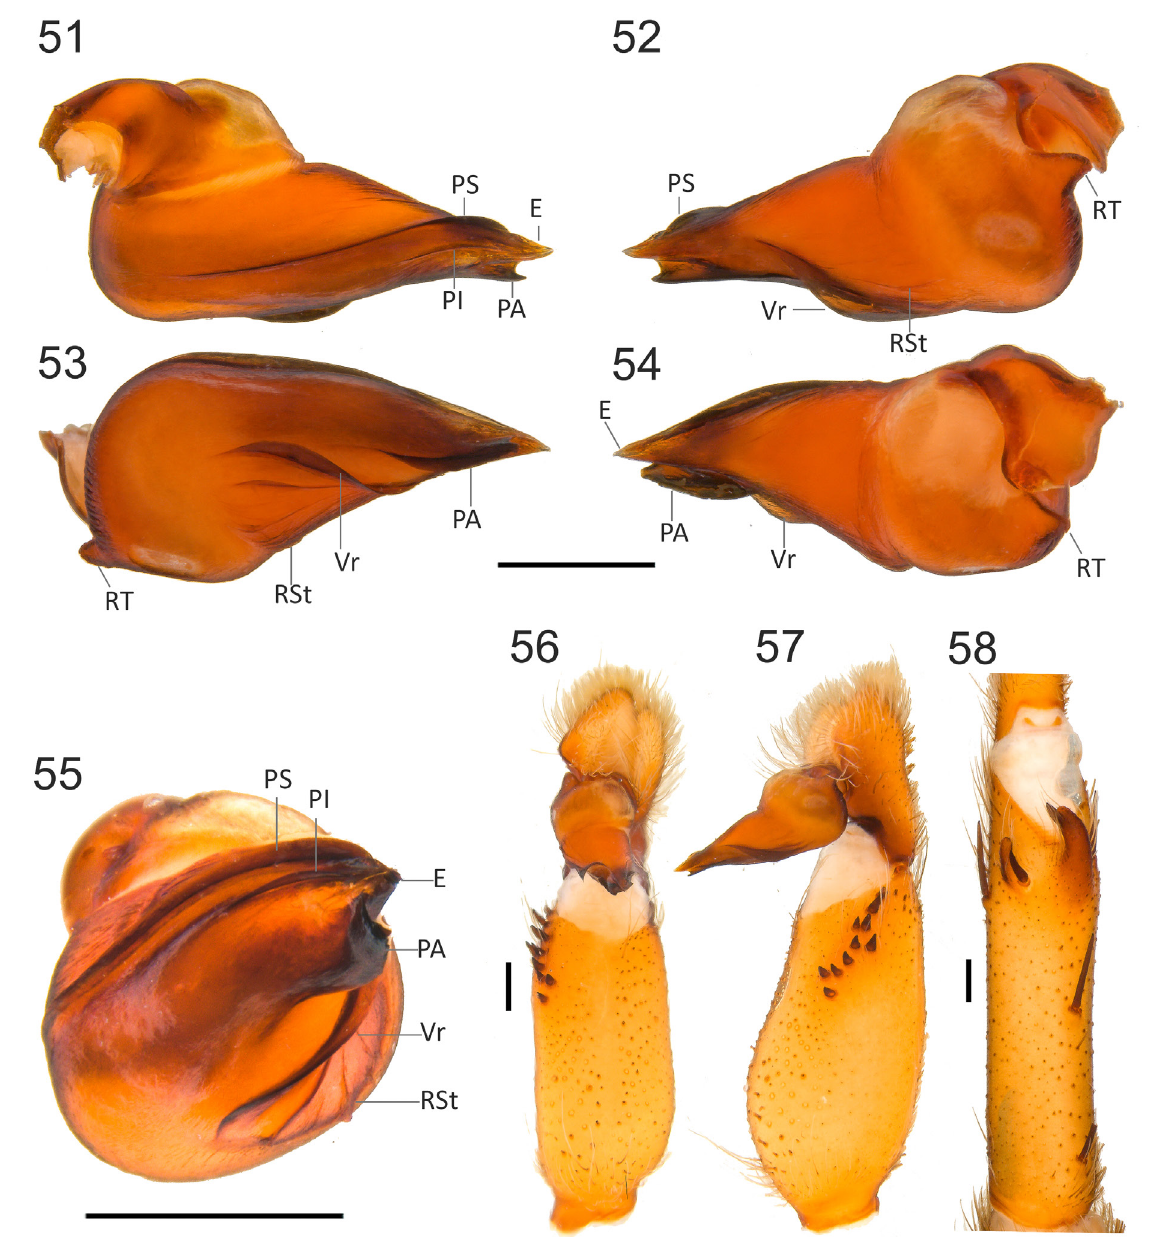
Figs 51–58 . Schismatothele moonenorum sp. nov., holotype, ♂ (IBSP 168510). 51–55 . Palpal bulb, prolateral (51), retrolateral (52), ventral (53), dorsal (54), and frontal (55) views. 56–57 . Palpal tibiae, right (56), and left (57). 58 . Tibial spur, ventral view. Abbreviations: E = embolus; PA = paraembolic apophysis; PI = prolateral inferior keel; PS = prolateral superior keel; RSt = retrolateral striae; RT = retrolateral tegular apophysis; Vr = ventro-retrolateral keel. Scale bars = 0.5